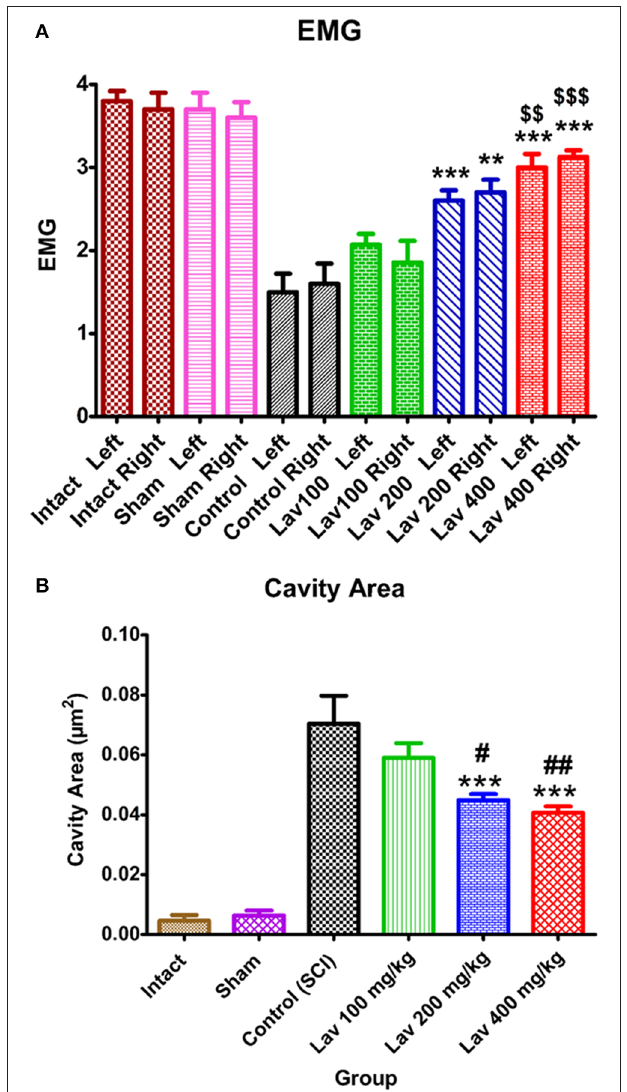
FIGURE 2 | Administration of L. angustifolia improved locomotor and EMG impairment in the rat spinal cord contusion model. Intraperitoneal administration of L. angustifolia extract daily for 14 consecutive days post-injury significantly improved the EMG results (A) and histomorphological evaluations (B) . Data are represented as mean ± SEM. (A) ** and *** show significant differences of the Lav 200 and 400 groups compared to the control group (SCI) ( P < 0.01 and P < 0.001 , respectively). $$ and $$$ show significant differences of the Lav 200 and 400 groups with the Lav 100 group ( P < 0.01 and P < 0.001 , respectively). (B) *** shows significant differences of the Lav 200 and 400 groups compared to the control group (SCI) ( P < 0.001 , respectively). # and ## show significant differences of the Lav 200 and 400 groups compared to the Lav 100 group ( P < 0.01 and P < 0.001 , respectively). (Per 35625 µ m 2 ).